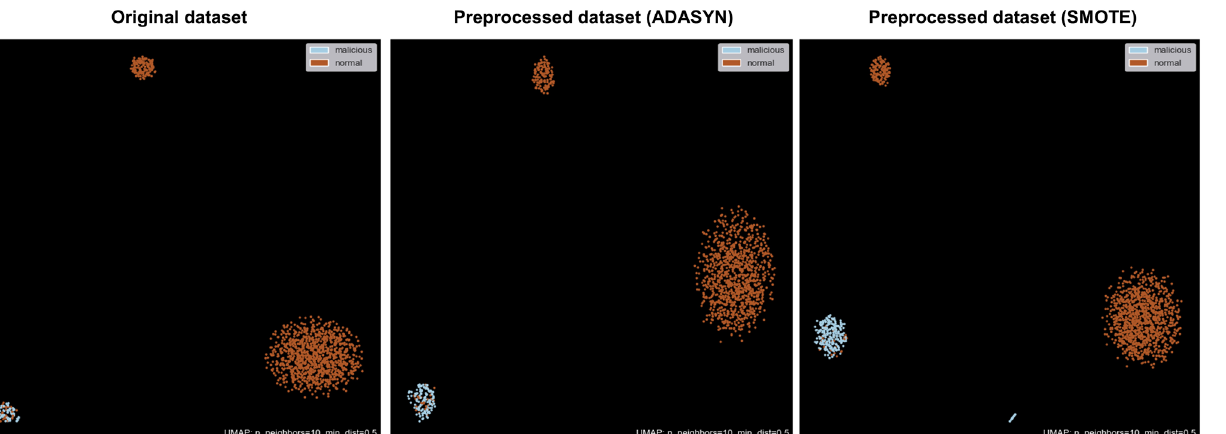
Figure 6. Data ratio pie graphs.